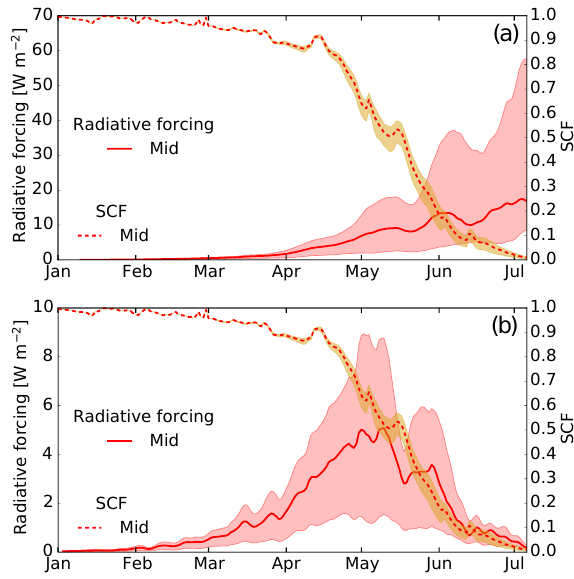
Figure 6. (a) Simulated mean catchment snow albedo (solid lines) and snow-covered fraction (SCF; dashed lines) for the mid (red lines), min, and max (shaded) estimates and for the scenario with- out ARF (no-ARF; black lines) averaged over the 6-year period. (b) Mixing ratio of BC in the model surface layer for the mid (solid line), min (lower bound of the shaded area), and max (upper bound of the shaded area) estimates.